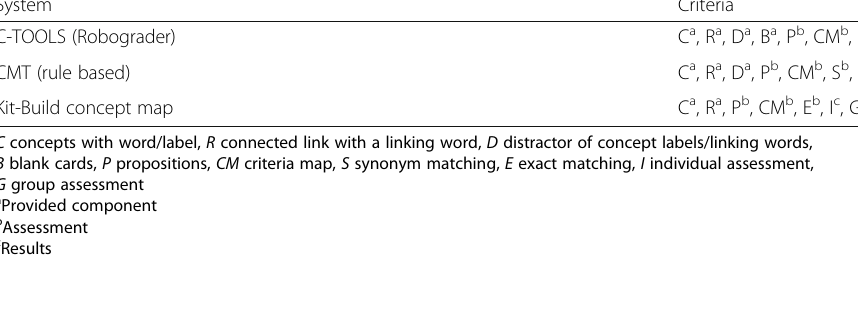
Table 1 The systems and assessment criteria System